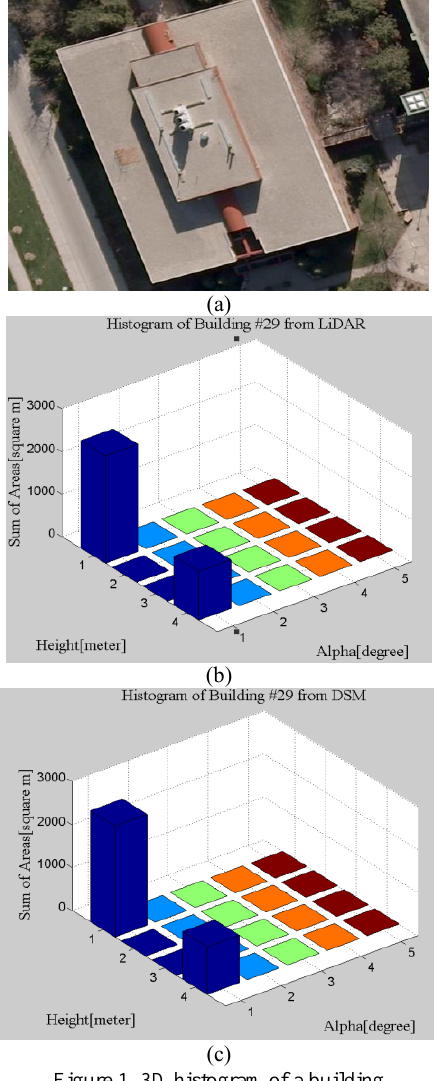
Figure 1. 3D histogram of a